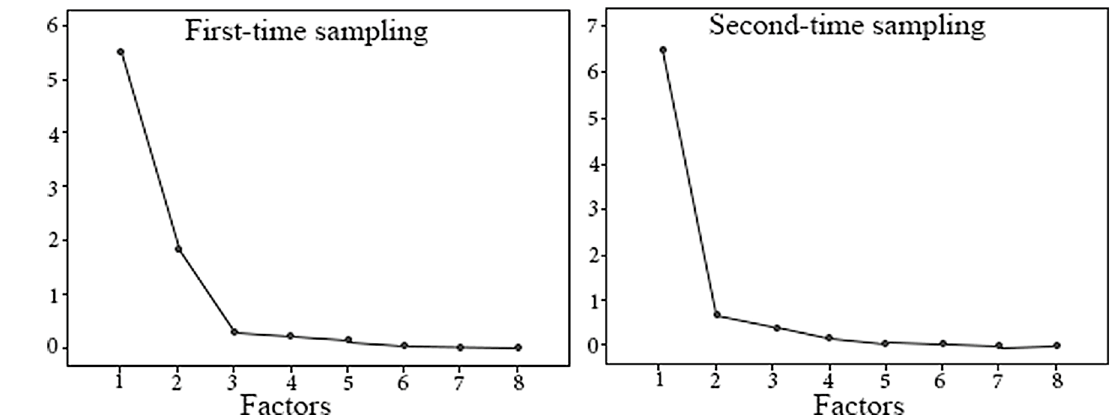
Fig. 8 Scree plot for studied parameters in the lake and downstream of the Gotvand-e-Olya Dam